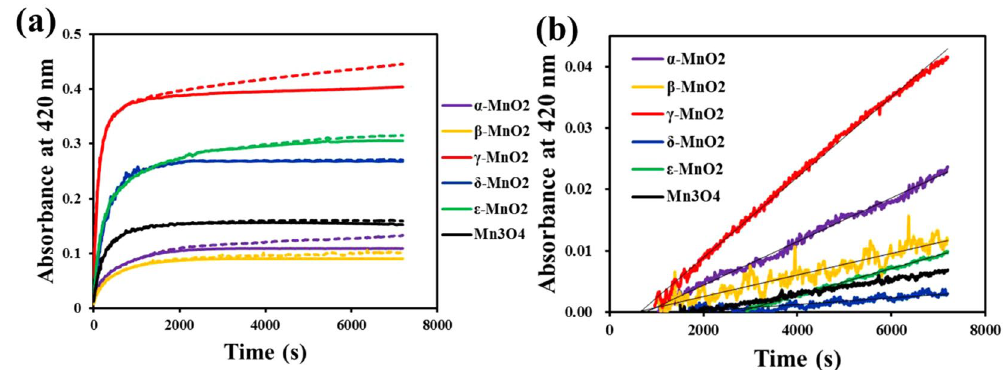
Figure 3. ( a ) The absorbance change from ABTS (2 mM) oxidation by MnO x (10.0 μ M) at pH 6.0 in systems with